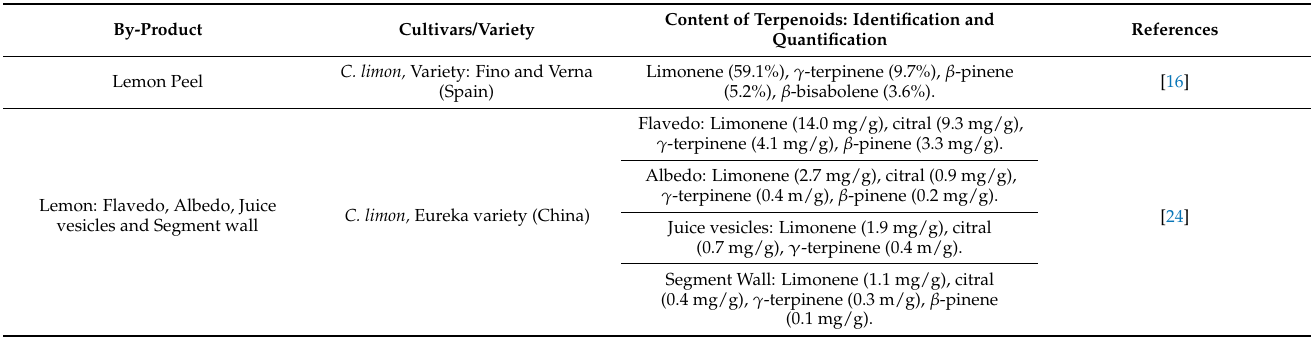
Table 1. Major terpenoids present in essential oils from lemon